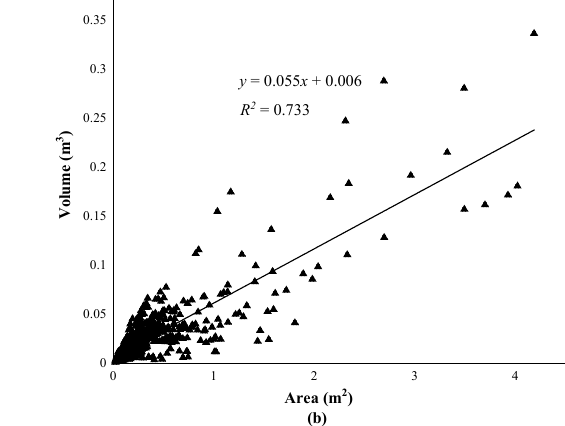
Figure 15. Comparison evaluation of the prediction indexes, including: ( a ) predicted and actual areas of the spalling defects and ( b ) predicted area and predicted volume.